Question: Name the type of graph shown.
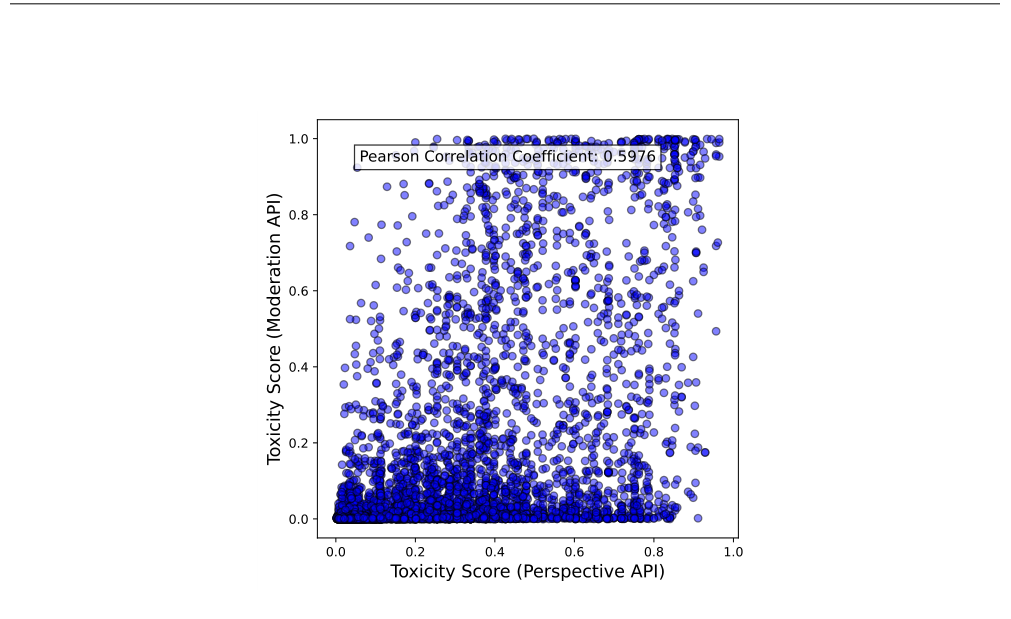
Answer: scatter